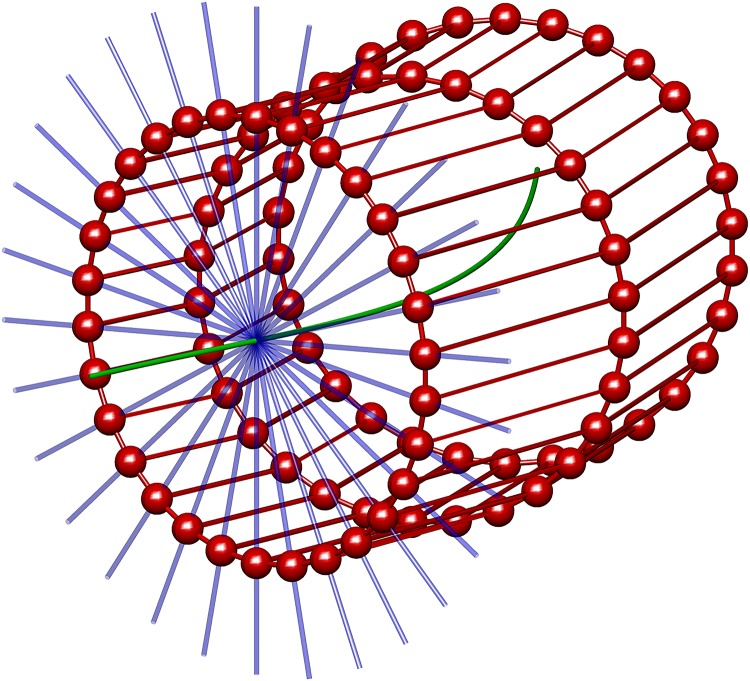
A simplified example of the graph structure described in section 2.6.At regular intervals along the centreline (green), a reference frame is extracted. In the image plane defined by this reference frame, a set of possible site locations are calculated by a radial coordinate system (blue). The set of sites corresponding to each reference frame may lie at any point along this ray. Here, for simplicity, the set of possible site locations for single a frame are shown, although the algorithm optimises over multiple frames. The sites are displayed as red spheres, connected by edges which describe their neighbourhood system. Neighbouring sets of rings correspond to neighbouring reference frames.